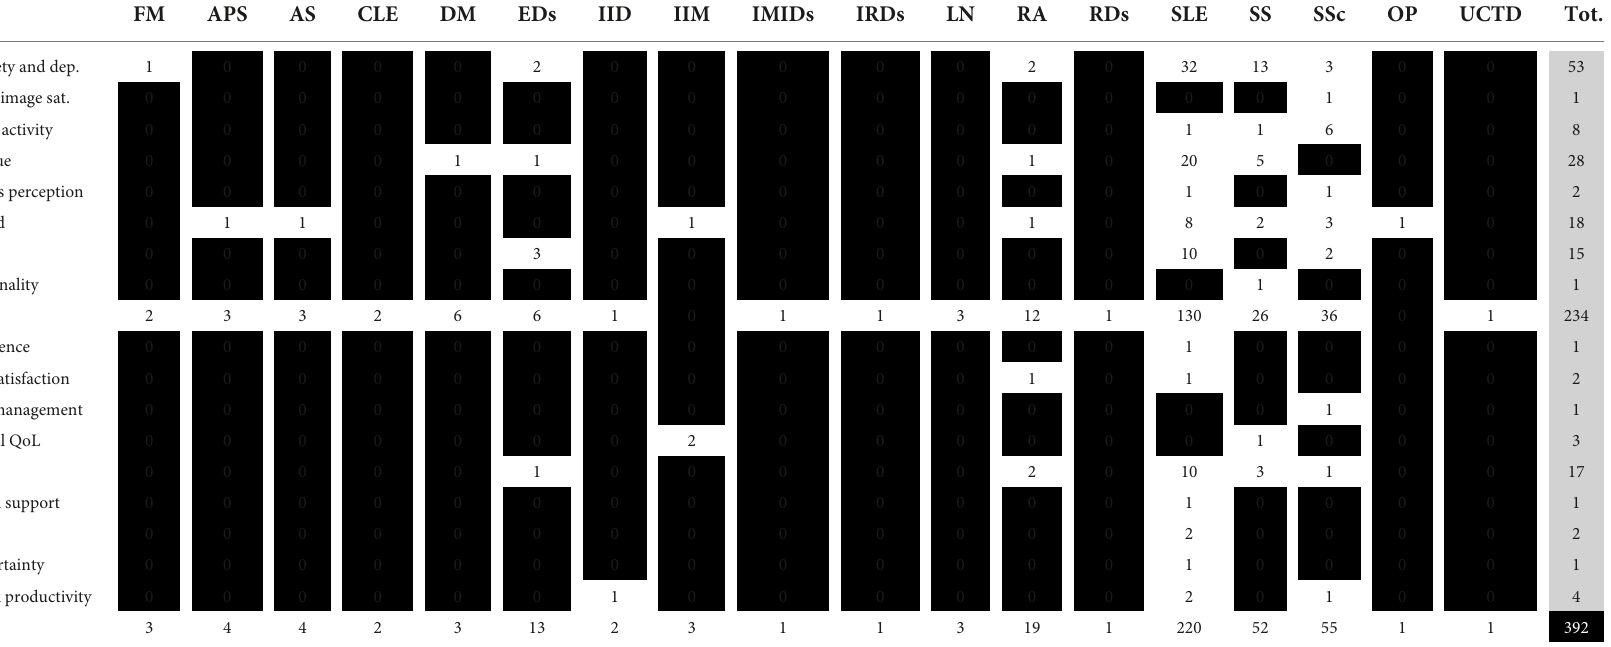
TABLE 3 Patient reported outcome measures (PROMs’) dimensions explored for each disease.